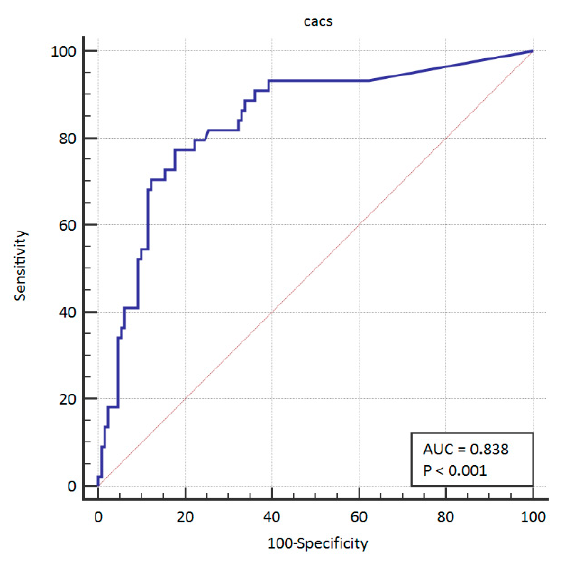
Figure 3. ROC curve for CACS in PCI + CABG together. ROC: receiver operating characteristic; PCI: percutaneous coronary intervention; CABG: coronary artery bypass surgery.